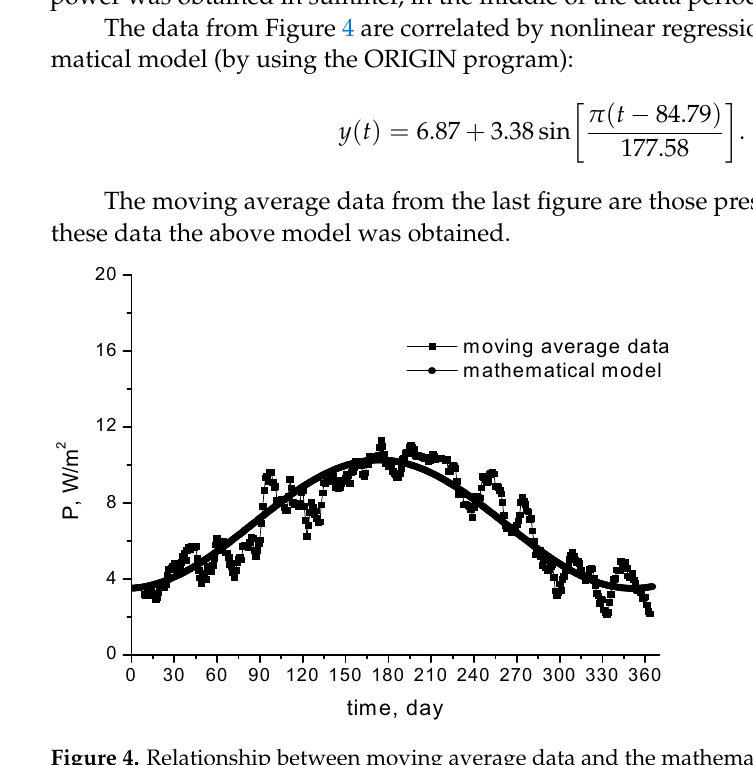
data moving average Figure 5. The moving average ( n = 6) applied to the weekly average data.